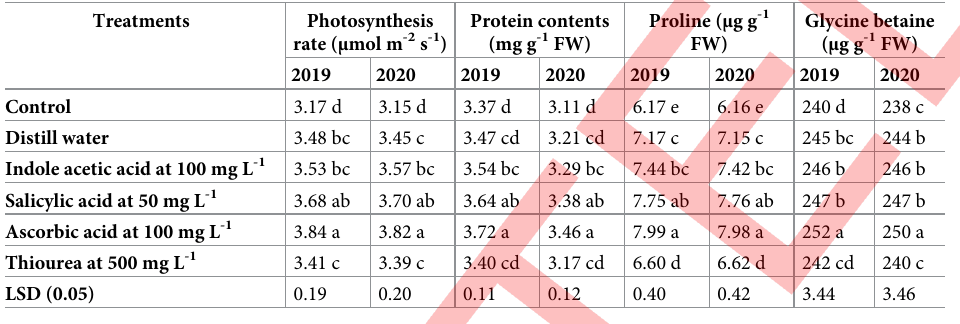
Table 4. The influence of seed priming with different growth regulators on photosynthesis rate, protein, proline, and glycine betaine contents of Indian squash under field conditions. Treatments